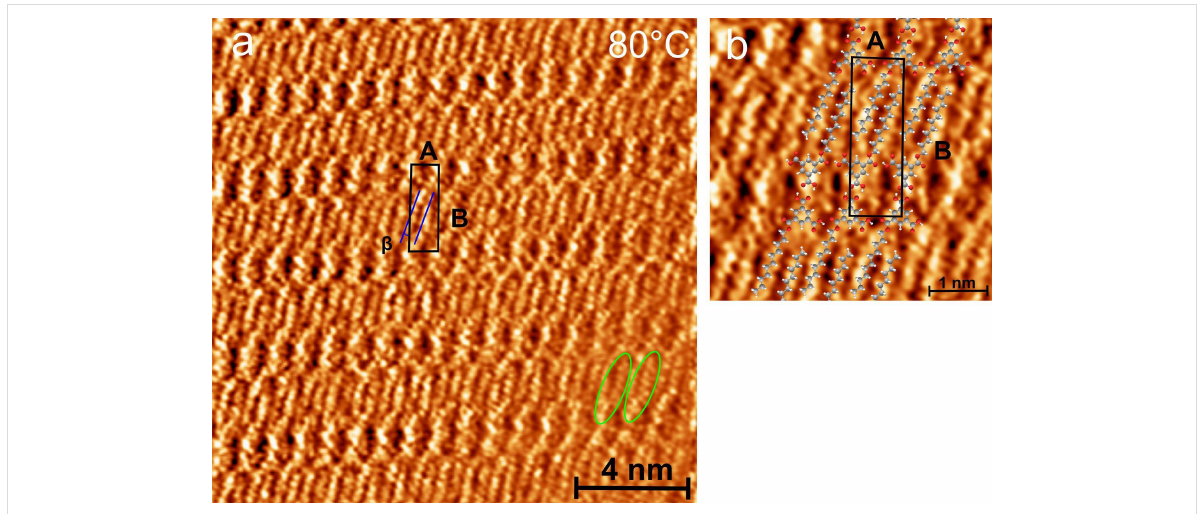
Figure 5: STM constant height images (1.2 V, 1.3 nA) of monoester obtained from a TMA–undecanol solution on HOPG (0001) deposited at ≈ 60–80 °C. (a) The parallelogram depicts the unit cell of the ester pattern where A and B are the corresponding unit cell parameters. (b) The force- field-optimized geometry of the monoester pattern overlaid on the STM image (5 × 5 nm 2 ).